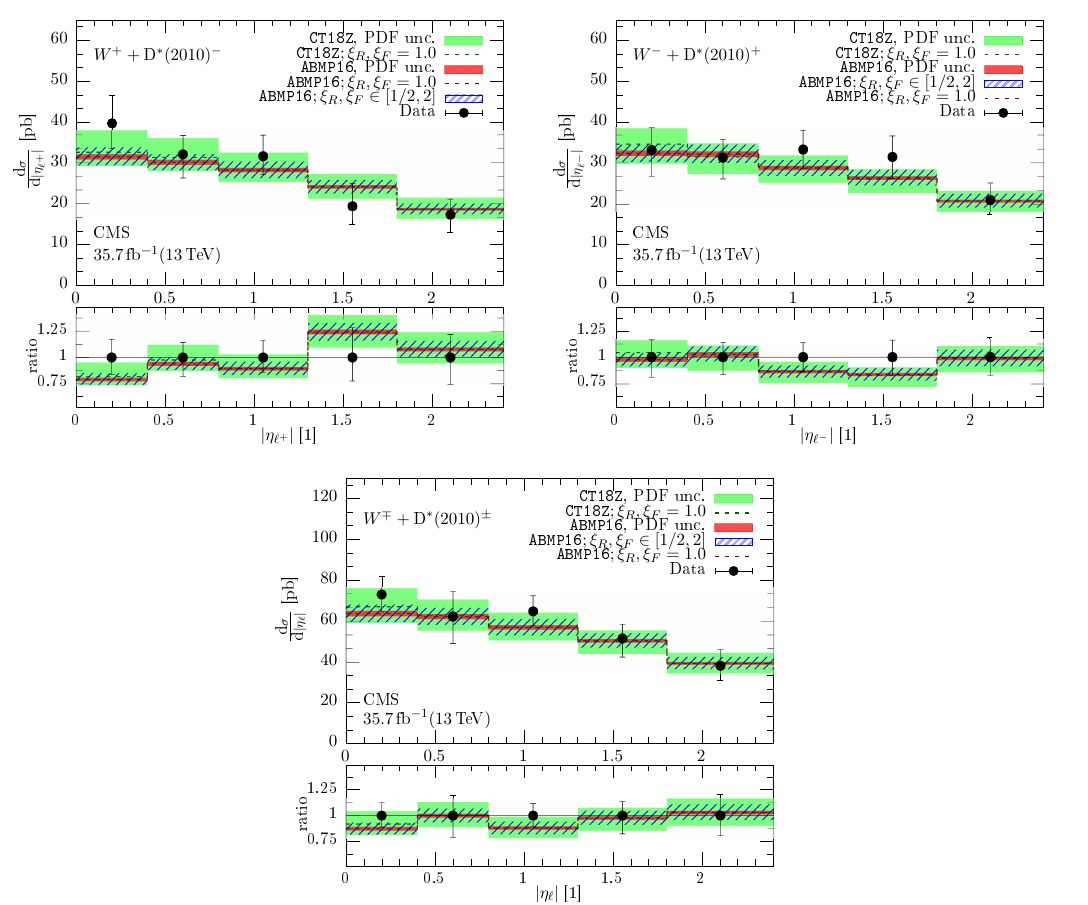
Figure 7 . Same as figure 6, but using the CT18ZNLO PDF set, with 2-loop α S evolution, α S ( M Z ) n f =5 = 0 . 118 and m c = 1 . 4 GeV, consistent with the PDF set. Asymmetric PDF uncer- tainty bands (green solid), computed at 90% C.L., corresponding to the tolerance criterion adopted in this PDF fit, refer to this configuration. Predictions from this configuration are compared to those using the ABMP16_3_NLO PDF set, with 2-loop α S evolution and α S ( M Z ) n f =3 = 0 . 1066 ( α S ( M Z ) n f =5 = 0 . 1191 ), consistent with the PDF set, and with m c = 1 . 5 GeV. For the latter, beside PDF uncertainty bands (red solid) computed at 68% C.L. as customary for this PDF fit, we also report scale uncertainties (blue hatched